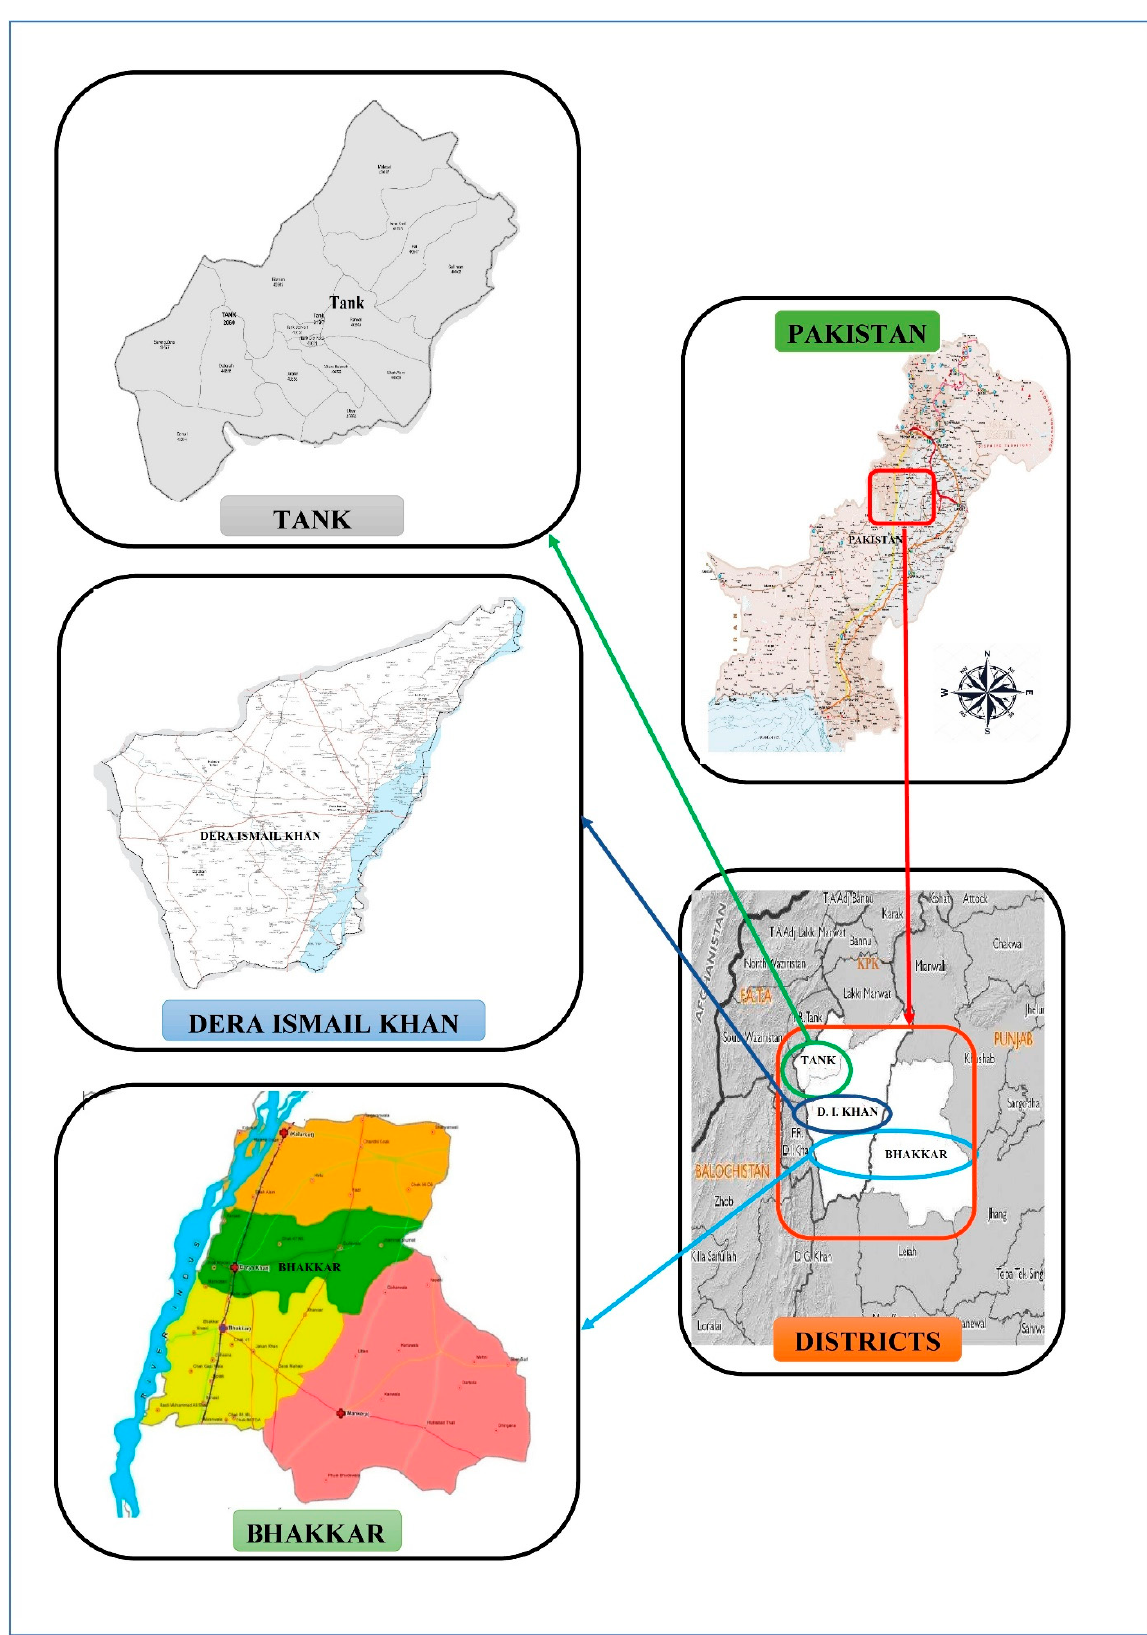
Figure 1. Map of the districts under study: Dera Ismail Khan, Bhakkar, and Tank. Source: [26,27,29].